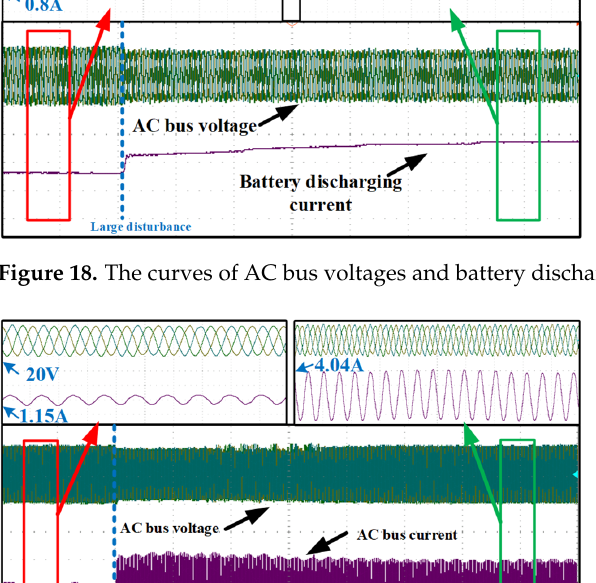
Figure 21. The curves of AC bus voltages and currents in discharging state (Group B).